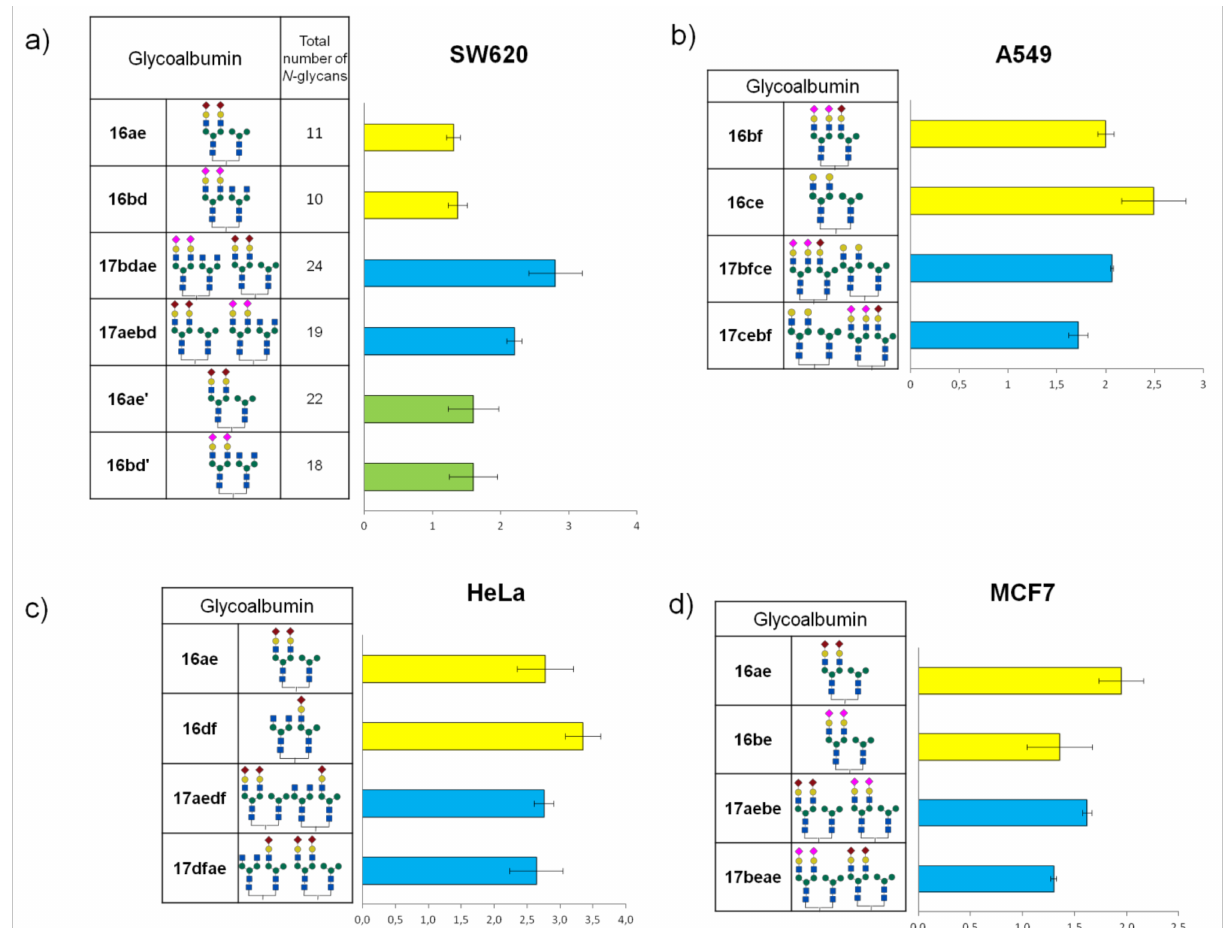
Figure 14. Heterogeneous glycoalbumins 17 containing four N -glycan moieties were incubated with corresponding cancer cell lines ( a ) SW620, ( b ) A549, ( c ) HeLa, and ( d ) MCF7, and the binding efficacy was compared with the same of glycoclusters 16 , carrying two different glycan fragments. Bars colored with yellow show fluorescence intensity of cells incubated with heterogeneous glycoalbu- mins 16 with two glycan fragments; blue bars—heterogeneous glycoalbumins 17 with four glycan fragments; green bars—glycoalbumins 16 (cid:48) containing about 20 glycan molecules. Fluorescence was averaged from 10,000 cells and normalized ( n = 4) [44]. Copyright Wiley-VCH GmbH. Reproduced with